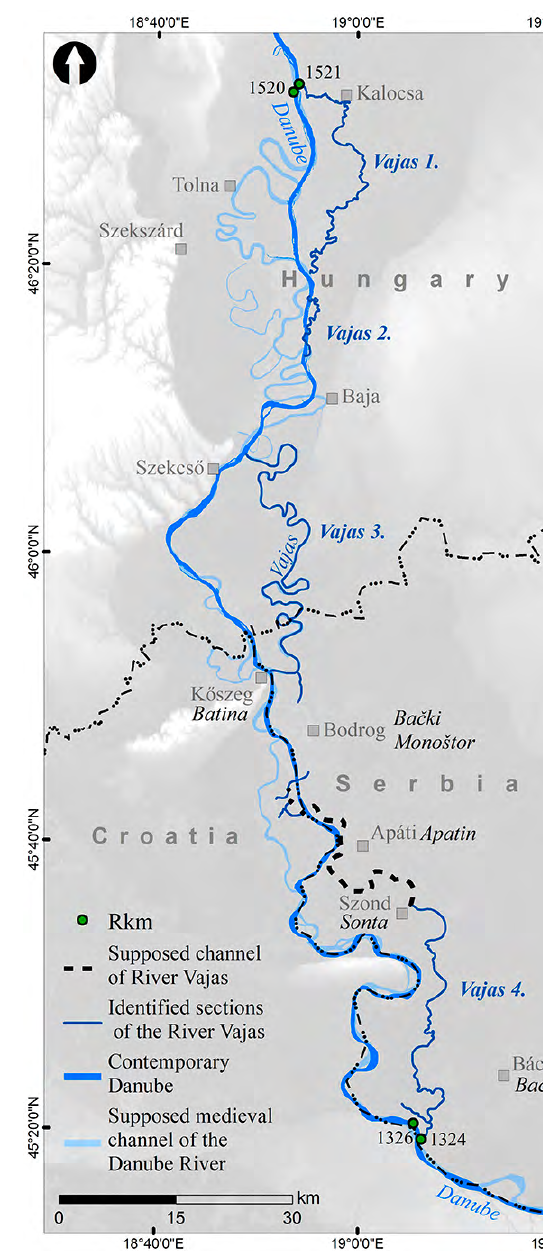
Figure 1. The River Vajas on GyörgyGyörffy’s map Source: Györffy, 1963